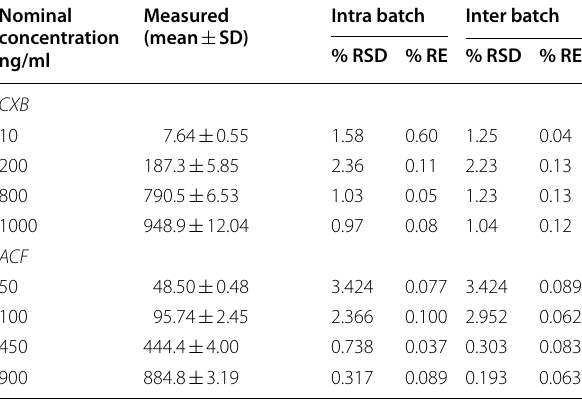
Table 2 Accuracy and precision for the analysis of CXB in rat plasma ( n 3 days, six replicates per day) = Nominal Measured Intra concentration (mean SD) ± ng/ml